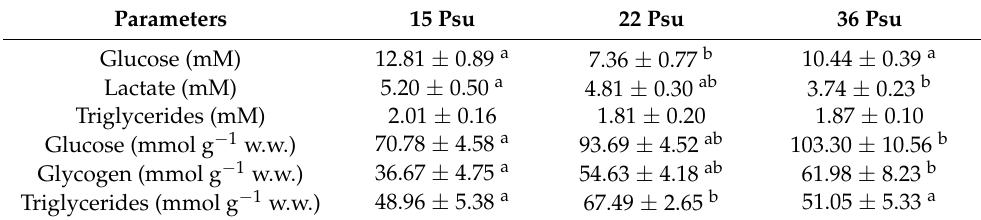
Glucose (mmol g − 1 w.w.) Glycogen (mmol g − 1